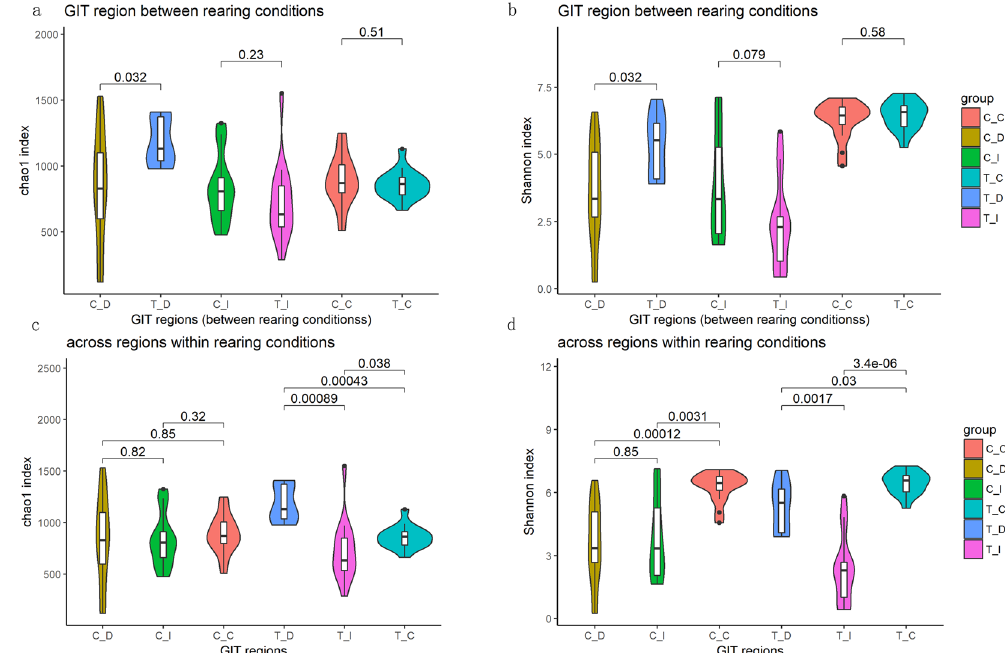
Figure 1. Alpha-diversity of luminal microbiota of the three gut regions under different rearing conditions. ( a , b ) Comparison of the richness (chao1 index) and diversity (Shannon index) of the specific GIT luminal microbiota under different rearing conditions. Violin plots showed that chao1 and Shannon indexes were significantly different between the 2 rearing conditions. ( c , d ) Comparison of the richness (chao1 index) and diversity (Shannon index) of the luminal microbiota of the three gut regions. Violin plots showed chao1 index were significantly higher in the duodenum of RPMF ducks. Shannon index were higher in the cecum independent of the rearing conditions. [ * P < 0.05, ** P < 0.01, *** P < 0.001 for Student’s